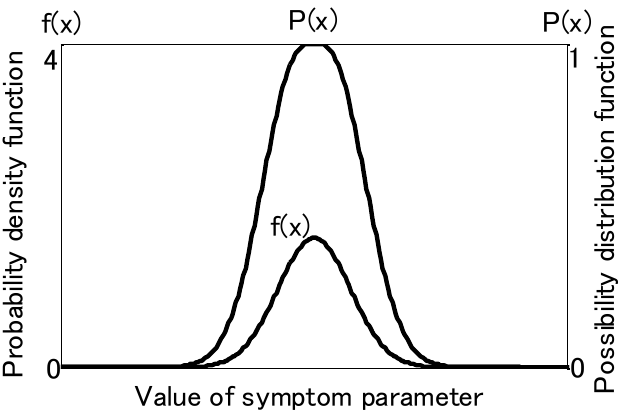
Figure 7. Possibility function and the probability density function.